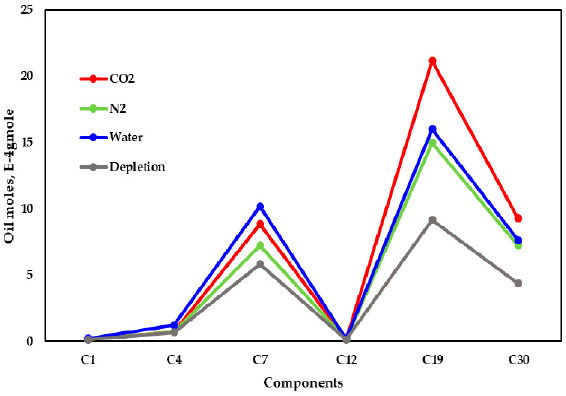
Figure 16. Production component comparison in Case-4.